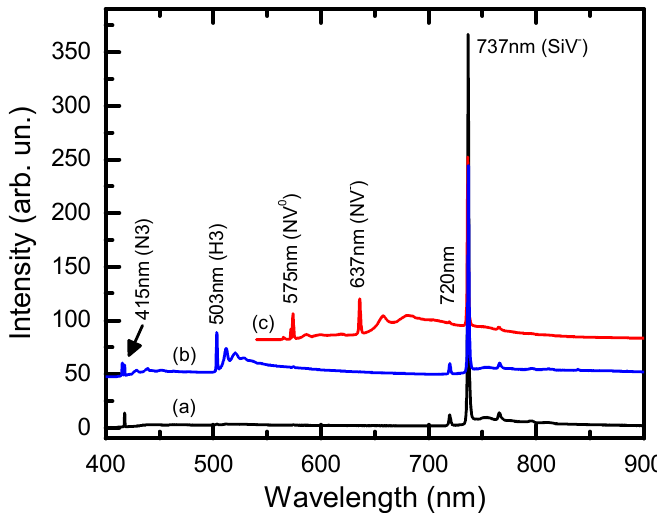
Figure5. RepresentativephotoluminescencespectraofdiamondcrystalssynthesizedintheMg-10wt%R 2 O 3 -C